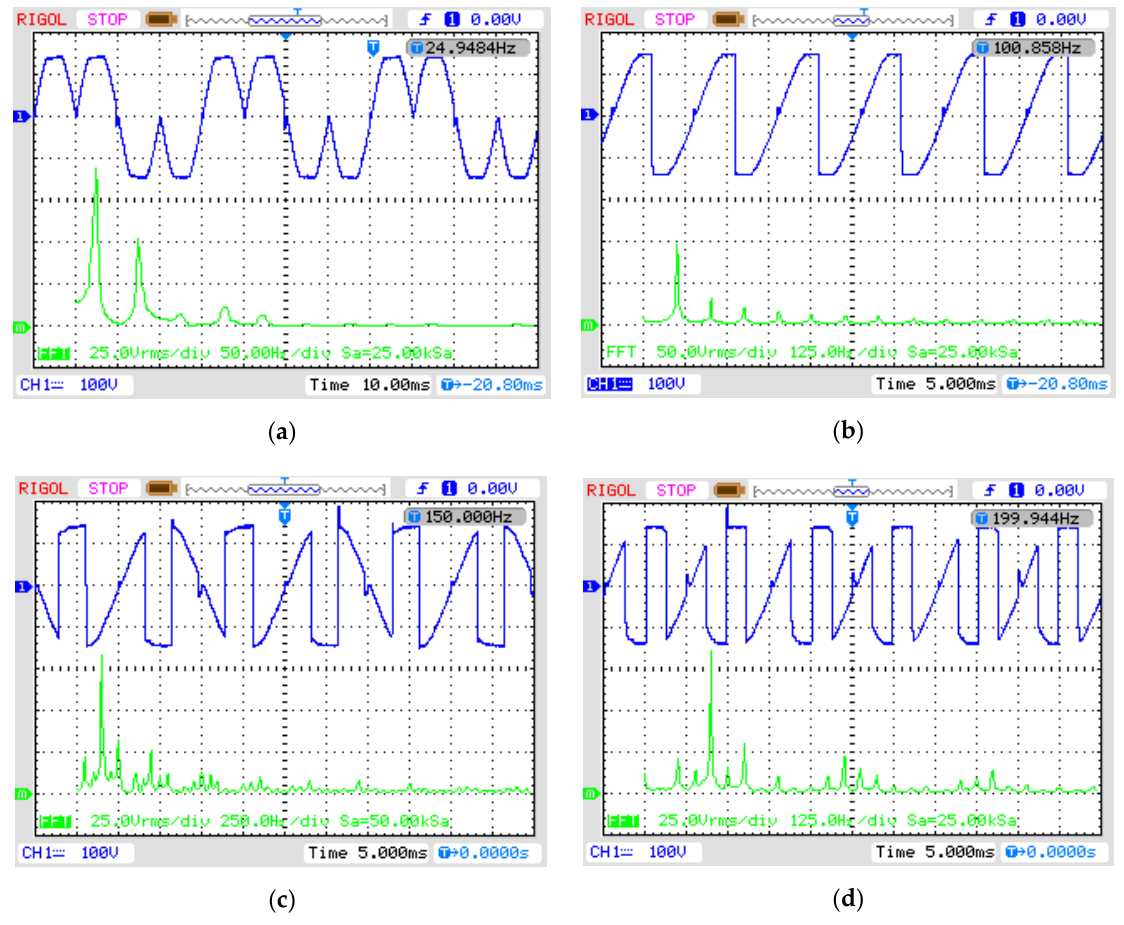
Figure 12. Practical waveform of the output voltage with output frequency: ( a ) 25 Hz; ( b ) 100 Hz; ( c ) 150 Hz; ( d ) 200 Hz.